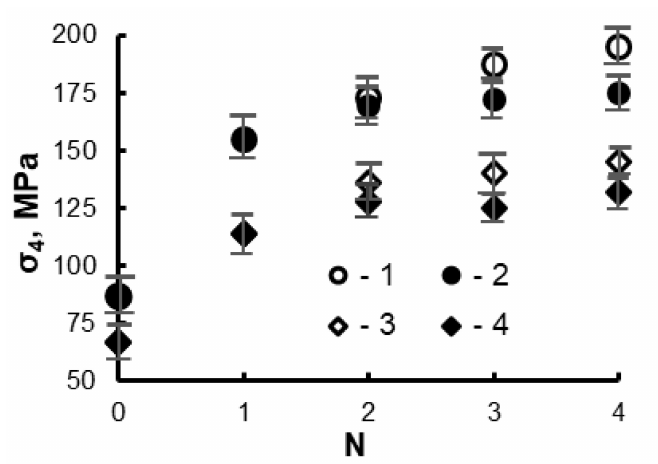
Figure 5. Effect of the number of ECAP passes ( N ) with routes A (1, 3) and C (2, 4) on the flow stress of the samples after their compression by 4% ( σ 4 ). 1, 2—sintered pure aluminum; 3, 4—Al-30Sn alloy.